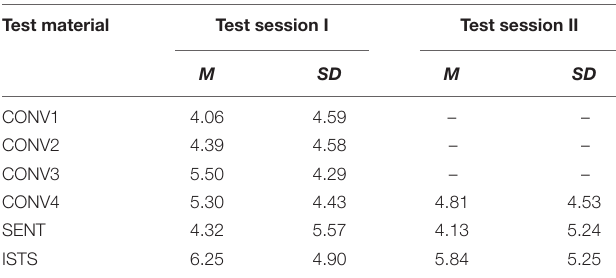
TABLE 3 | Acceptable noise level (ANL) descriptive statistics for the six speech materials and the two test sessions (in dB). Test